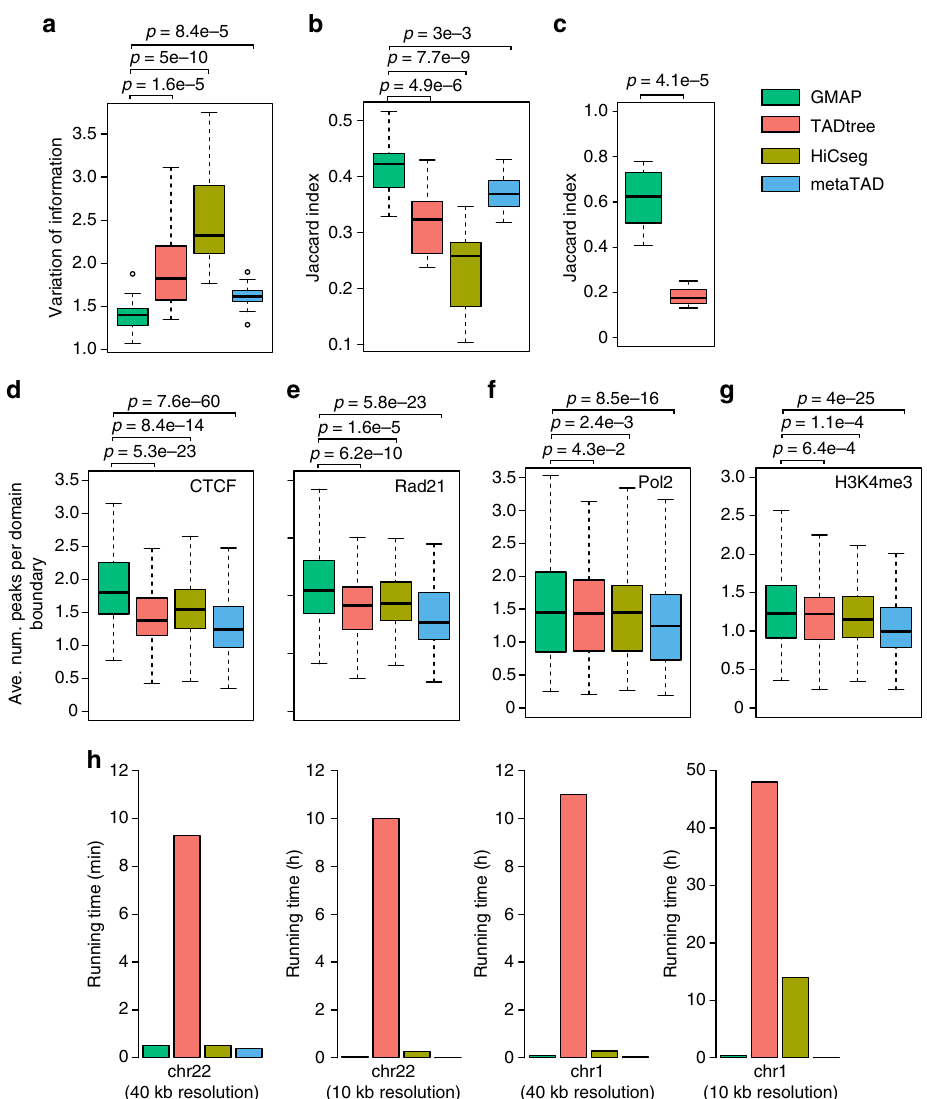
Fig. 3 Performance comparison using experimental Hi-C data . a , b Similarity between TADs called using low-resolution (10 kb) and high-resolution (10 kb) Hi-C data. Hi-C data for the human lung fi broblast cell line, IMR90, was obtained from refs 1,4 . Similarity was measured using Variation of Information ( left ) and Jaccard Index ( right ). c Similarity between subTADs called using Hi-C and 5 C data. No data is shown for HiCseg and metaTAD since they do not call subTADs. Average number of CTCF peaks d , Rad21 peaks e , Pol2 peaks f , and H3K4me3 peaks g per TAD boundary. Values represent the average number of peaks within a TAD boundary plus 25 kb fl anking regions on either side of the boundary across all chromosomes and six cell types (IMR90, GM12878, NHEK, HMEC, HUVEC, and K562). P -values are based on paired t -test. The whiskers represent the most extreme data point which is no more than 1.5 times the interquartile range. h Running speed of different